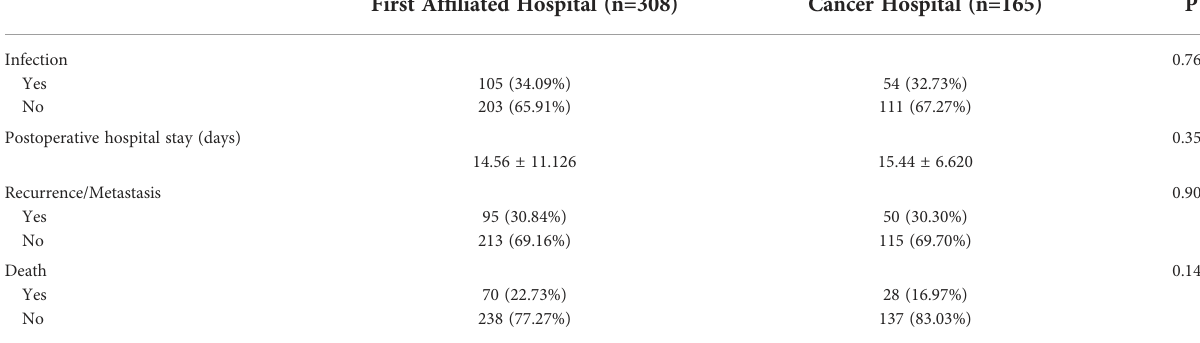
TABLE 5 Comparative analysis of the two